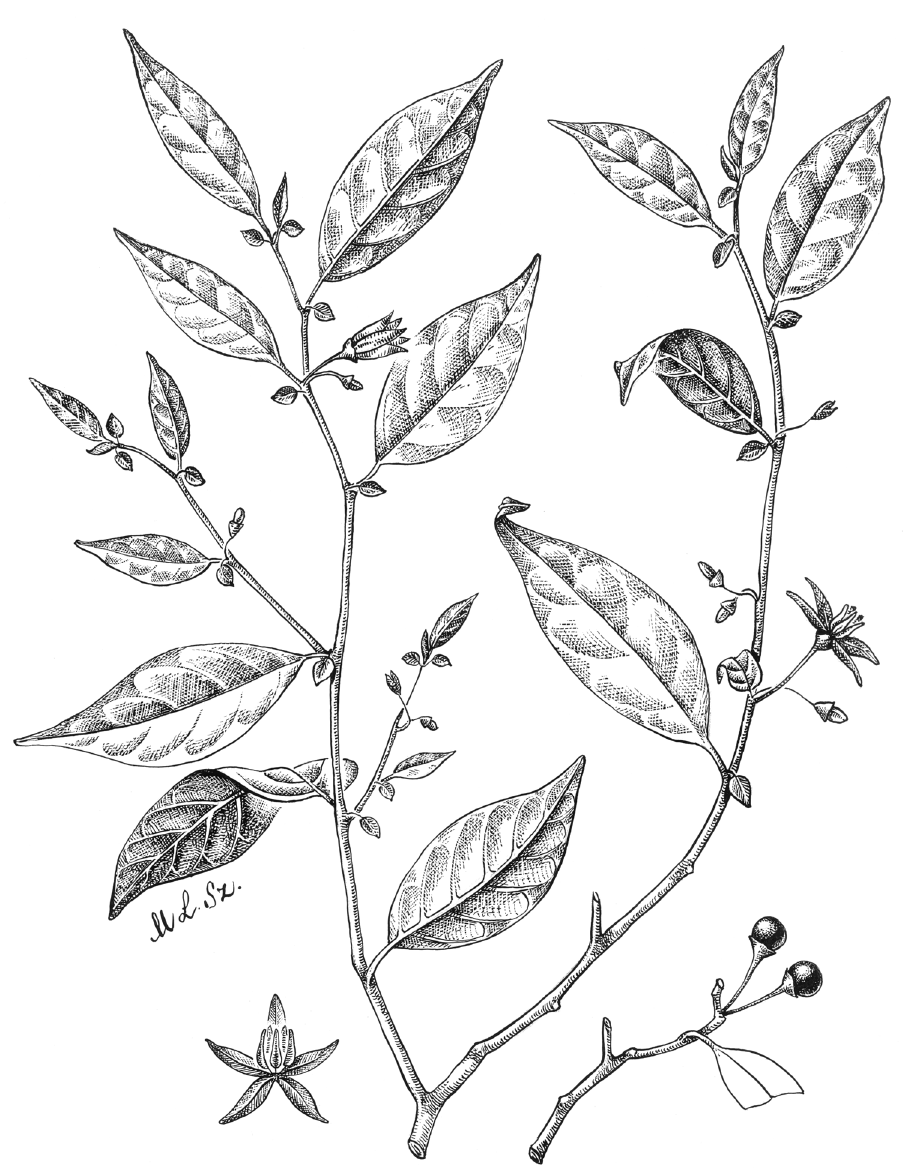
Figure 45. Lycianthes rostellata (Merr. & L.M.Perry) A.R.Bean. Drawing by M.L. Szent-Ivany, first pub- lished in Symon (1985: fig. 19, as S. pustulatum Symon). Courtesy of the Board of the Botanic Gardens and State Herbarium (Adelaide, South Australia), reproduced with